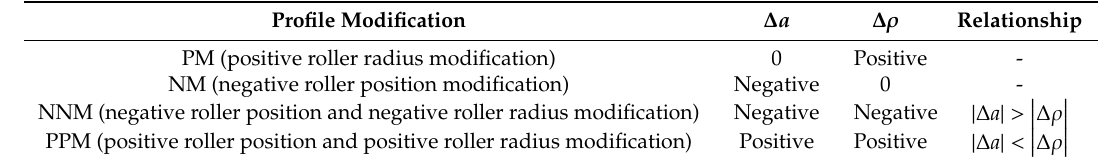
Figure 3. The four types of tooth profile modifications for cycloid gears.